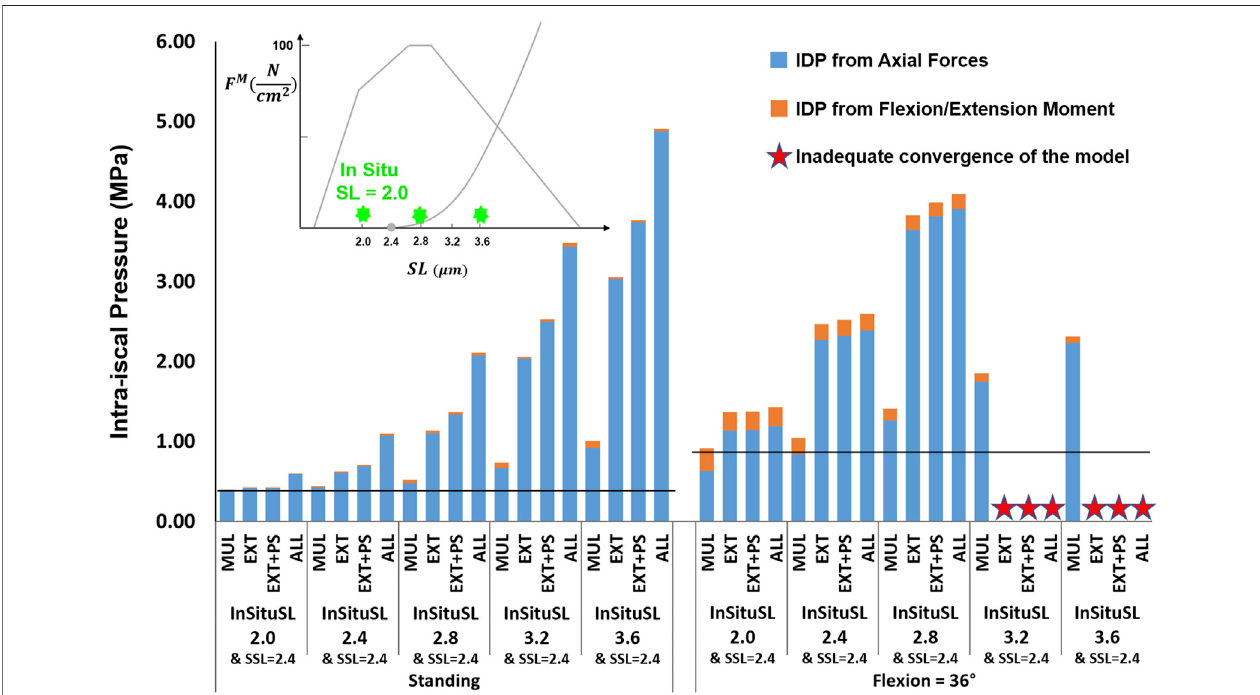
FIGURE 9 | The effect of different supine/prone in situ sarcomere lengths combined with a slack sarcomere length (SSL) of 2.4 μ m to the targeted muscles on L4- L5 IDP in upright standing and 36 ° fl exion for four scenarios: changes applied to multi fi dus (MUL), extensor muscles (EXT), extensor muscles and psoas (EXT + PS), and all 210 muscles in the model (ALL). The black horizontal lines represent the baseline values.